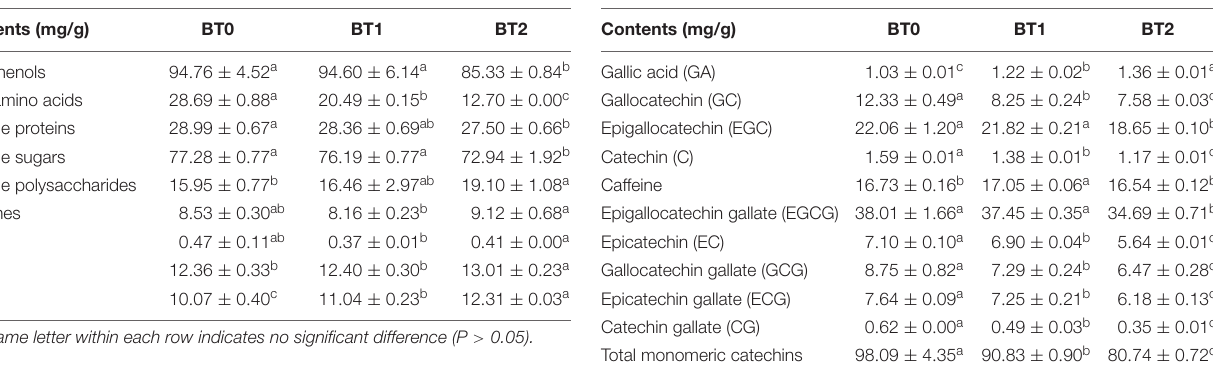
TABLE 2 | The contents of monomeric catechins, gallic acid, and caffeine in jade (BT0), medium-baked (BT1), and deep-baked (BT2) Tieguanyin oolong